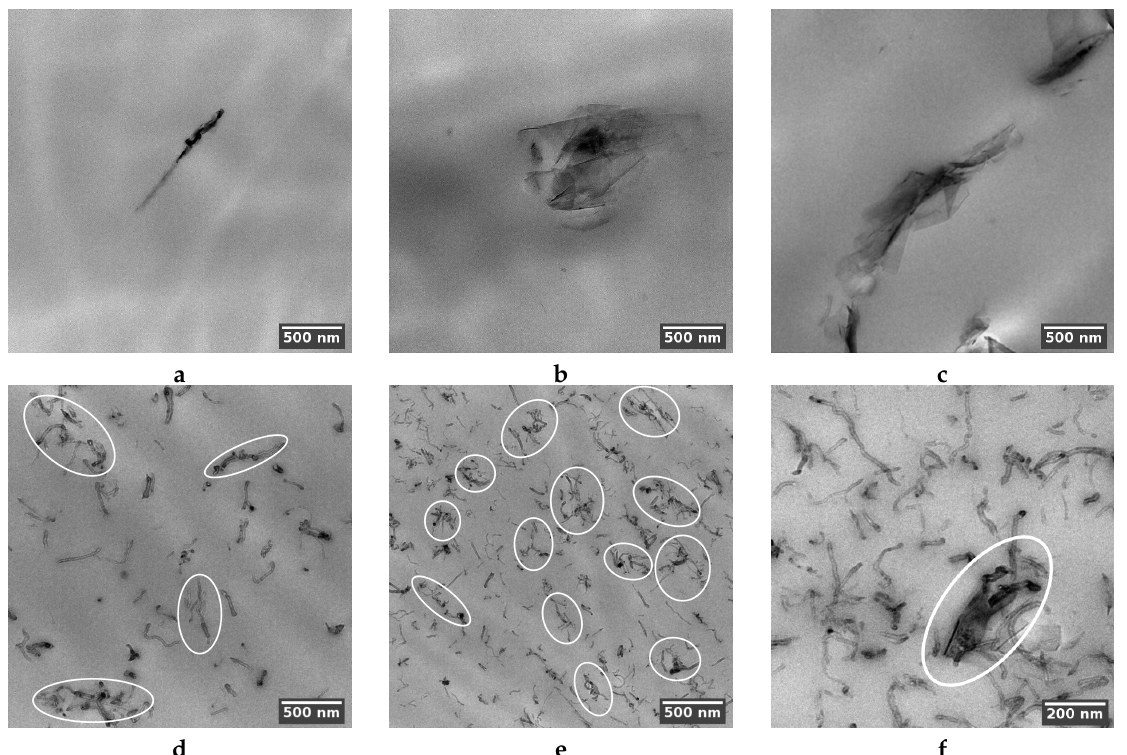
Figure 2. TEM images of insulated filler particles in PLA composites with 1.5 ( a ), 3 ( b ), and 6 wt.% ( c ) GNP; insulated particles and percolating clusters (enclosed in ovals) in composites containing 1.5 ( d ) and 3 wt.% ( e ) MWCNT; the mixture of 3% GNP and 3% MWCNT ( f ). A graphene nanoplatelet involved in percolation contact with nanotubes is enclosed in an